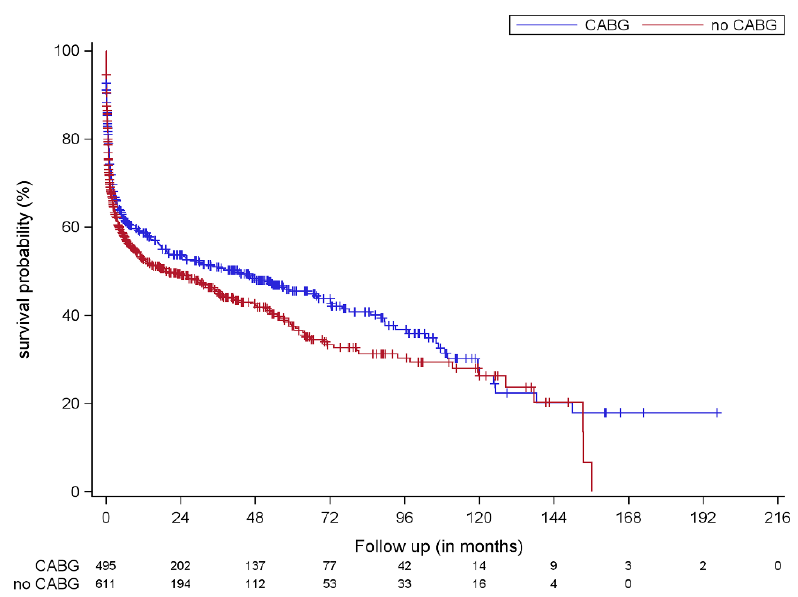
Figure 2. Kaplan–Meier survival estimates of all patients with coronary artery disease comparing those who received concomitant CABG (blue line) to those who did not receive concomitant CABG (red line). CABG: coronary artery bypass grafting. Table 5. Risk factors for mortality by multivariate Cox regression analysis among patients with CAD during the follow-up period.